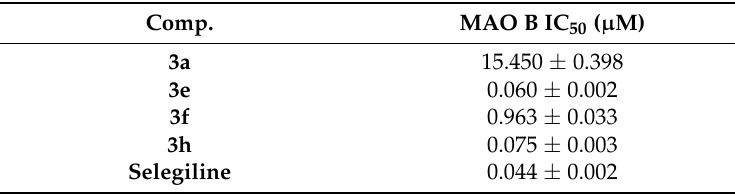
Table 2. IC 50 values of 3a , 3e, 3f, and 3h and selegiline against MAO-B.